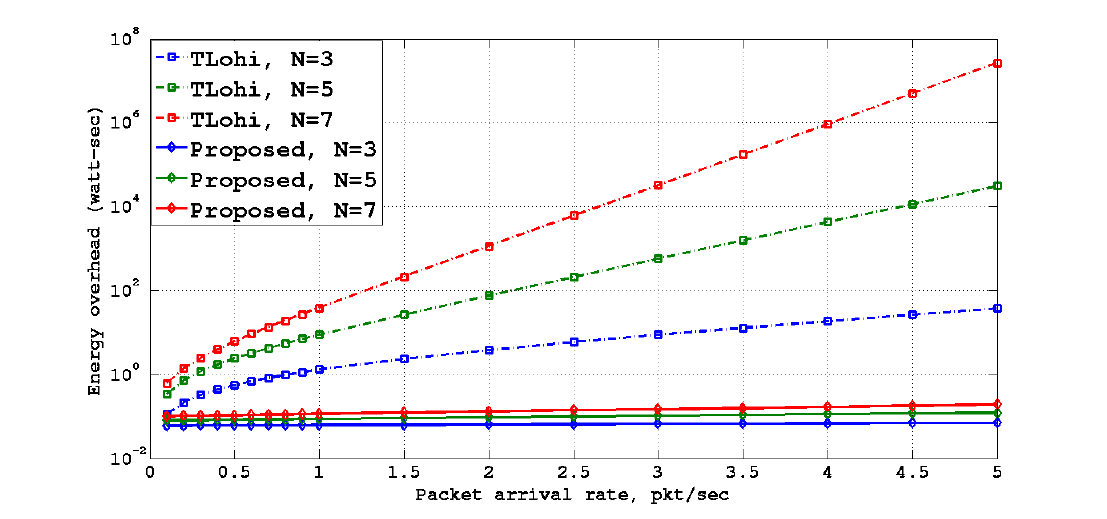
Figure 7. Energy overhead vs. packet arrival